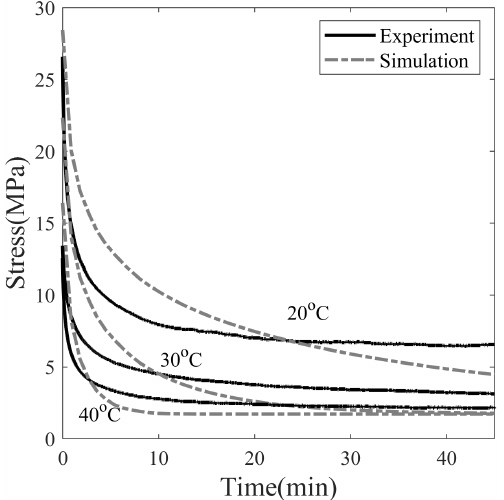
Figure 11. Effect of programming temperature on stress relaxation of SMP at 20% pre-strain.